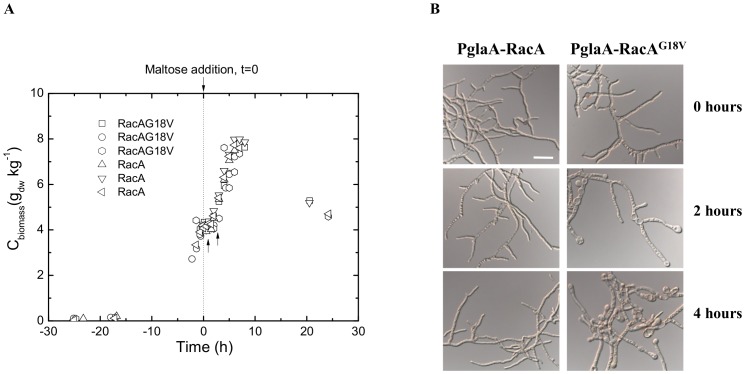
Biomass accumulation and morphology during submerged cultivation of PglaA-RacAG18V and PglaA-RacA mutant strains.(A) Growth curve for both mutant strains. The dashed line indicates the time point when the inducing carbon source maltose was added. The two arrows indicate the time points at which samples for transcriptome analysis were taken. (B) Dispersed hyphal morphology at the time point of maltose addition as well as 2 and 4 h after maltose addition. Bar, 20 µm.